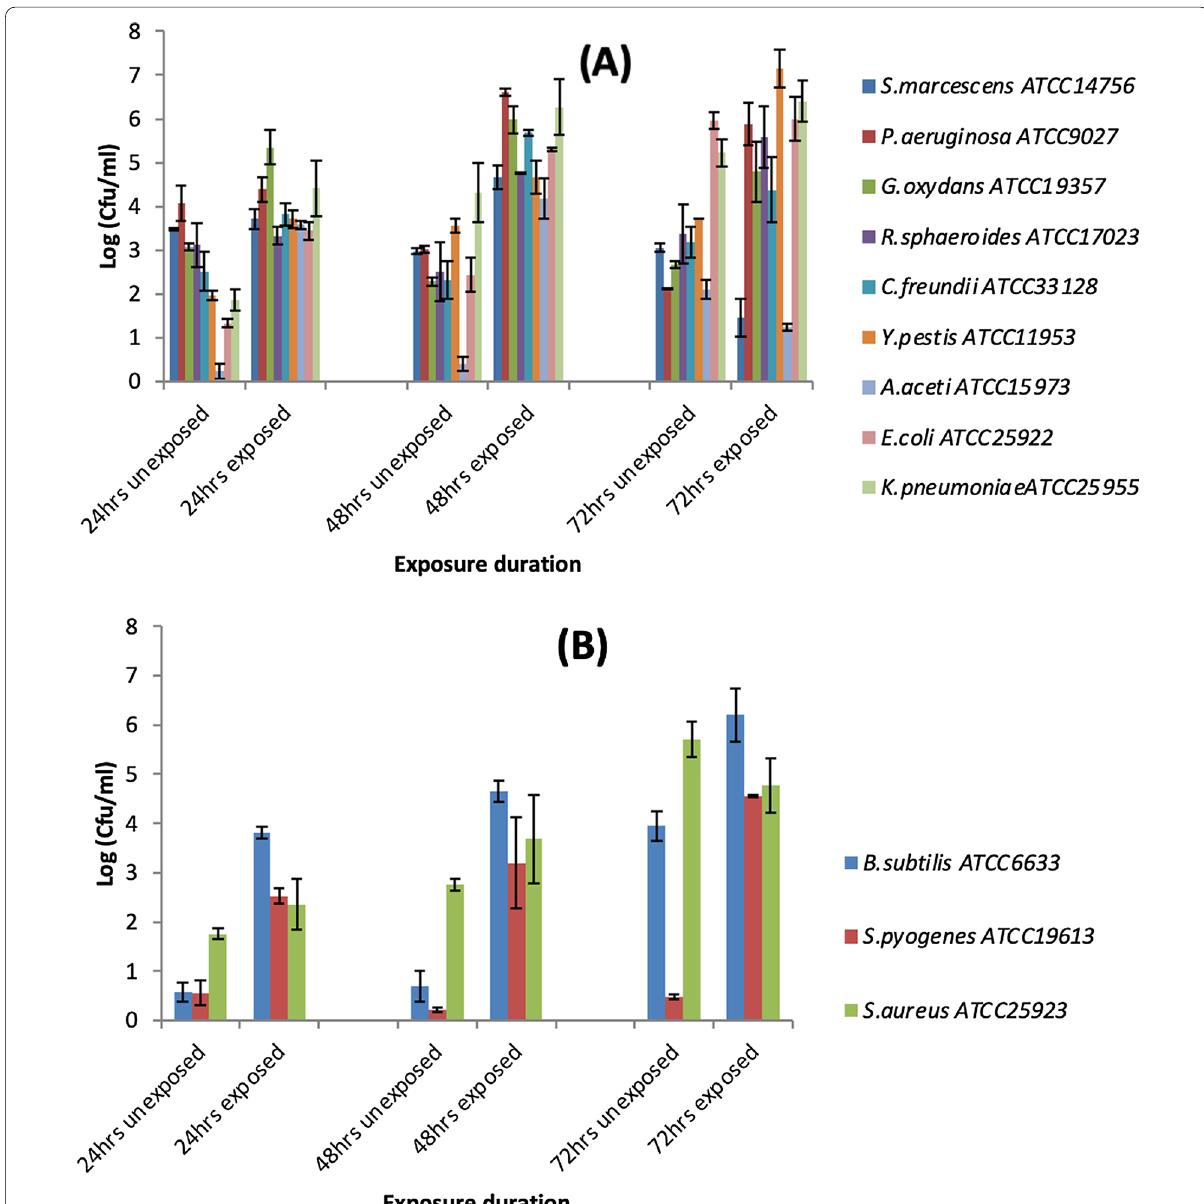
Fig. 2 Growth rate of selected Gram‑negative ( a ) and Gram‑positive bacteria ( b ) after exposure to acoustic treatment at 1125 Hz/80 dB compared with unexposed